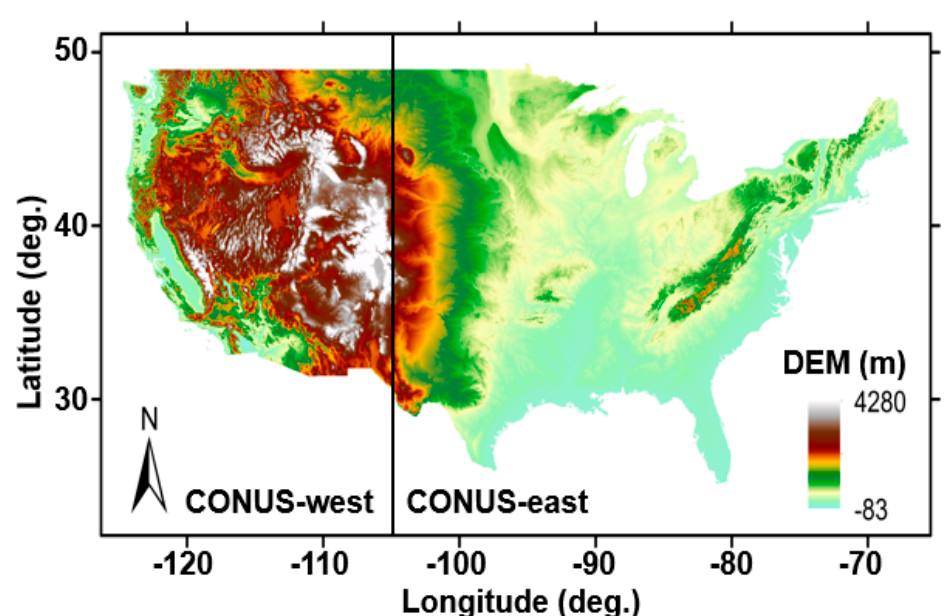
Figure 1. The digital elevation model (DEM) map over the CONUS. The thick black line indicates the meridian 105°W, which divided the study domain into CONUS ‐ east and CONUS ‐ west.